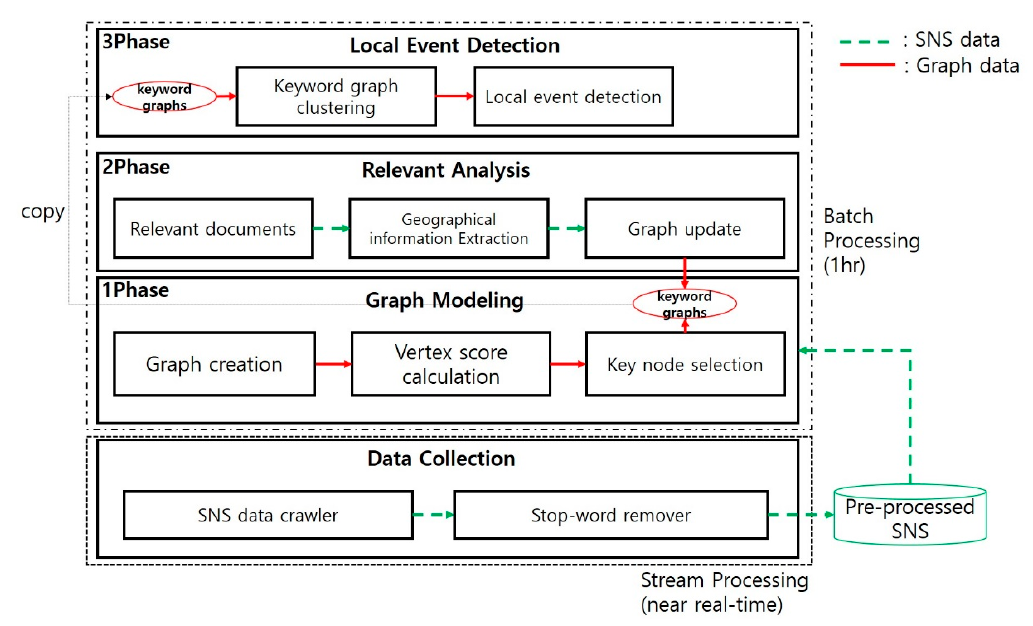
Figure 1. Overall architecture of the proposed local event detection scheme.